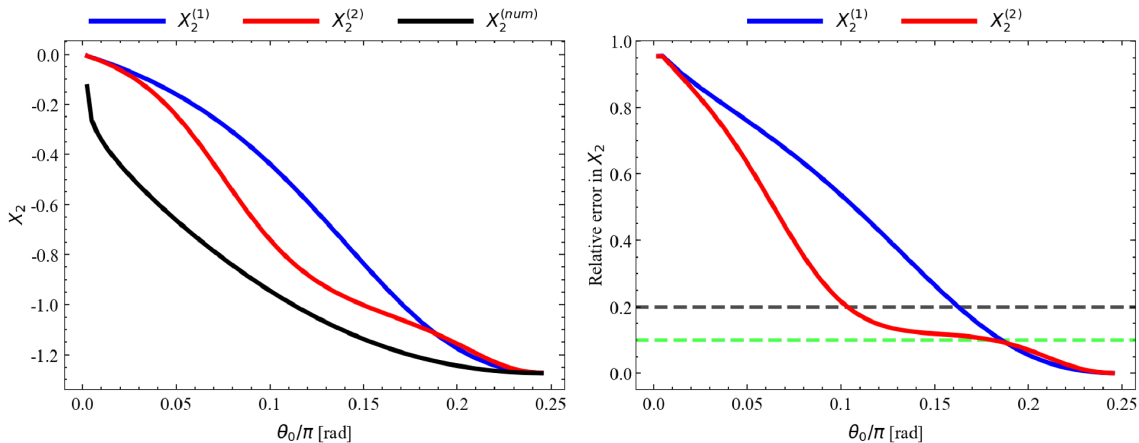
1 Þ ð 2 Þ 2 ; X 2 (blue, red) of the quadrupole coefficient and the exact numerical 1 Þ ð 2 Þ 2 ; X 2 (blue, red) compared to the exact value as functions of